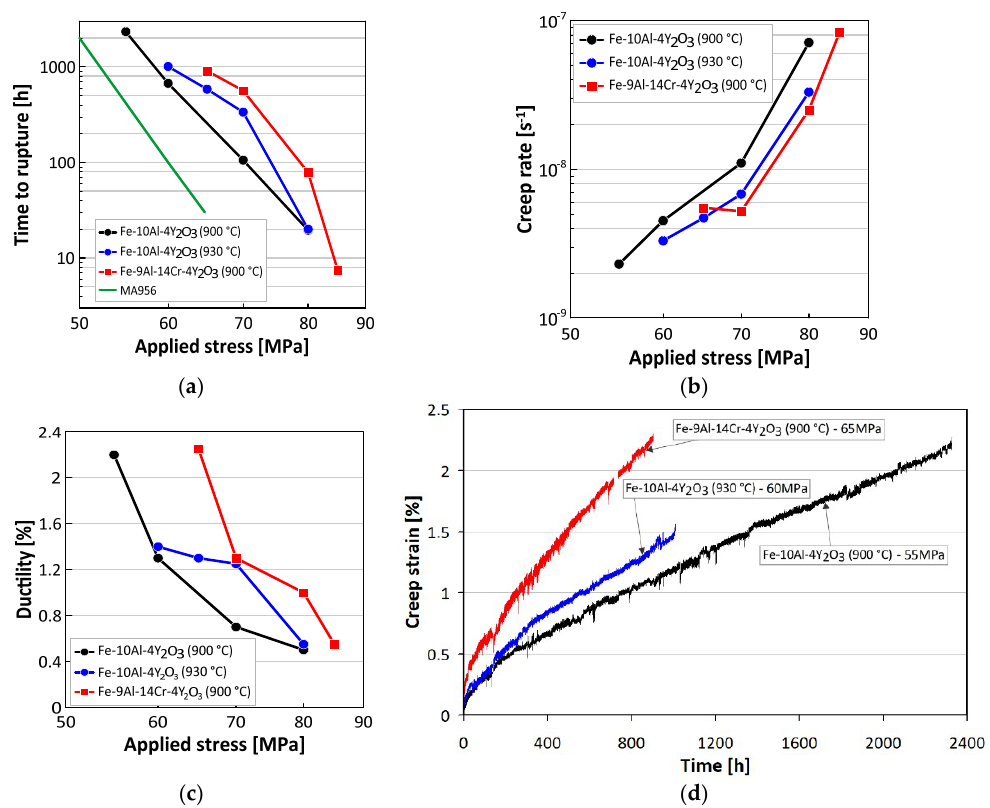
Figure 6. Summarizing results creep at 1100 °C of the most promising heats Fe-10Al-4Y 2 O 3 rolled at 900 °C and 930 °C and Fe-9Al-14Cr-4Y 2 O 3 rolled at 930 °C, ( a ) dependences of time to fracture on applied stress, ( b ) dependences of secondary creep rate on applied stress, ( c ) dependences of ductility on applied stress, and ( d ) longest creep curve of the studied heats.